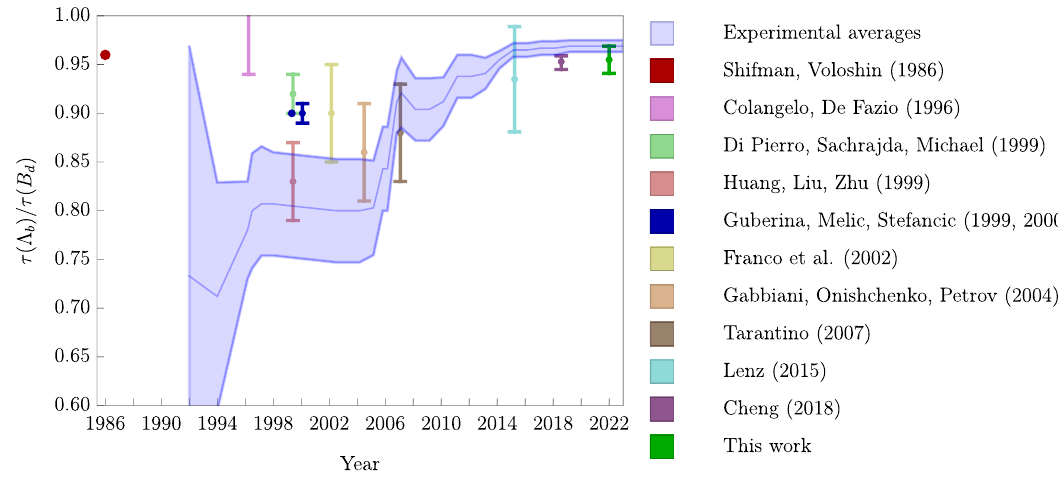
Figure 1 . History of the lifetime ratio τ (Λ b ) /τ ( B d ) : experiment (lilac) vs. selected theory predic- tions: Shifman, Voloshin (1986) [1], Colangelo, De Fazio (1996) [5], Di Pierro, Sachrajda, Michael (1999) [6], Huang, Liu, Zhu (1999) [7], Guberina, Melic, Stefancic (1999, 2000) [8, 9], Franco et al. (2002) [10], Gabbiani, Onishchenko, Petrov (2004) [11], Tarantino (2007) [12], Lenz (2015) [2], Cheng (2018) [13], and this